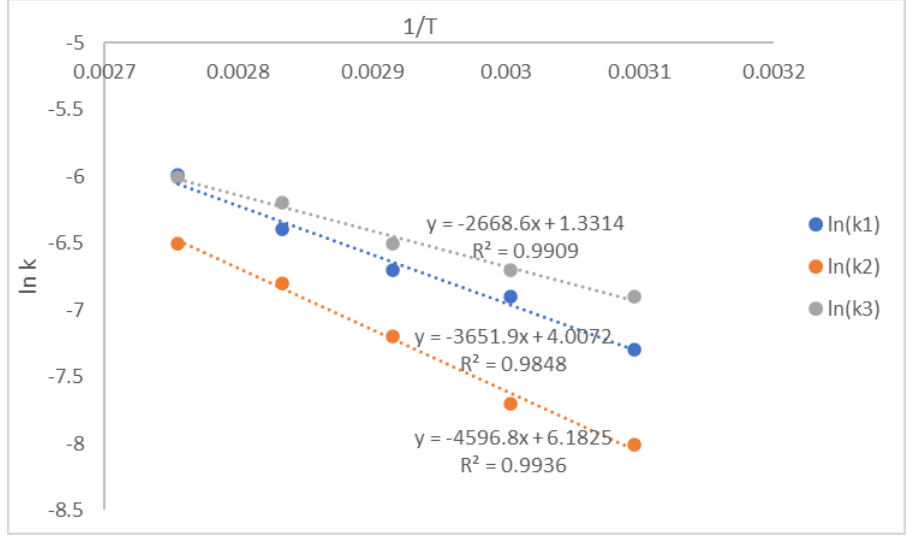
Figure 11. The plot of ln (k i ) versus 1/T for hexogen coating with polyurethane-based